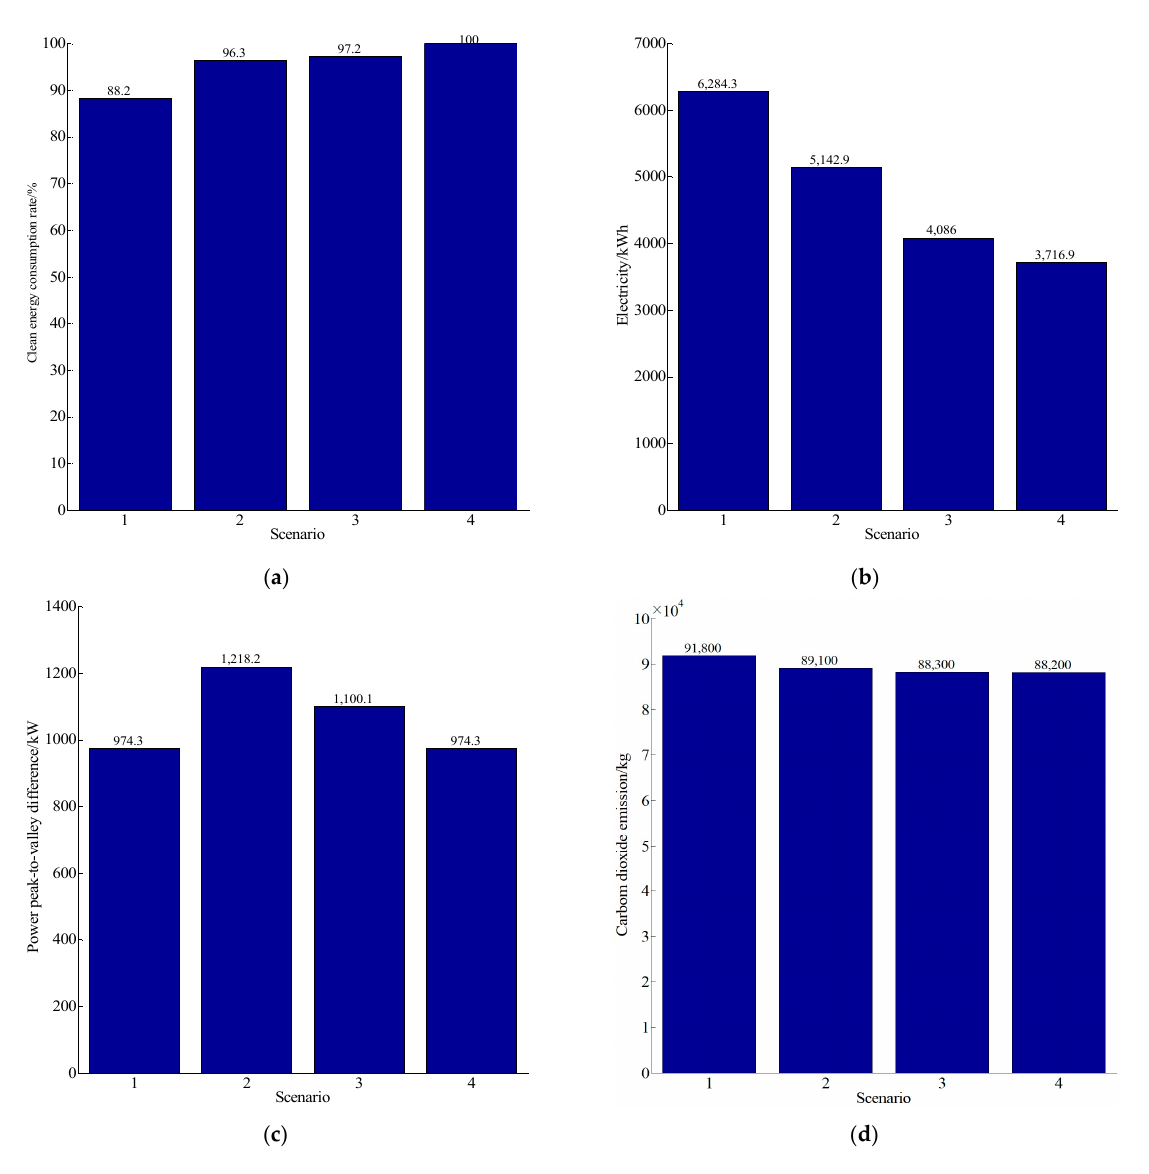
where k 1 and k 2 represent the penalty factor for burning coal and the penalty factor for burning natural gas in the external grid, respectively. We take k 1 = 1.2 and k 2 = 1.75. A comparison of each index for the four scenarios can be seen in Figure 7.